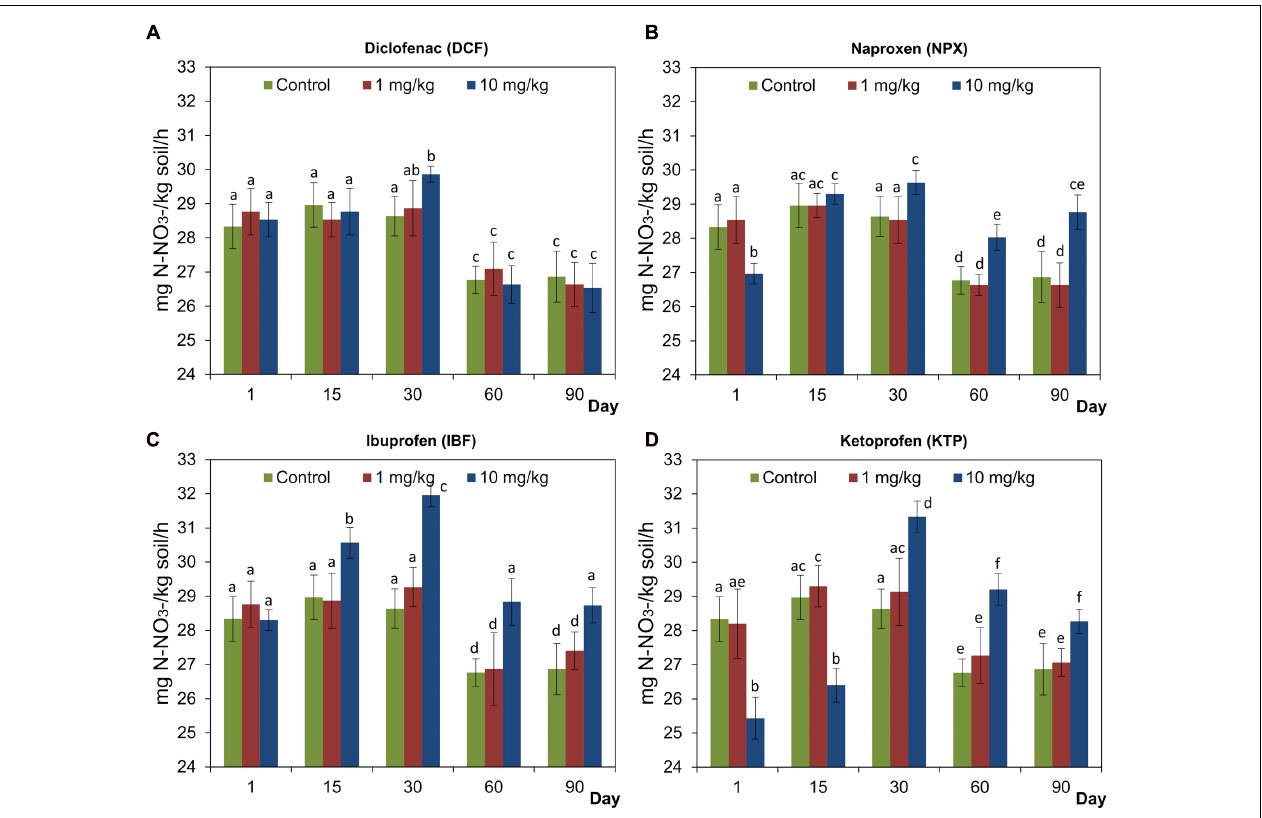
FIGURE 7 | Concentration of N-NO 3 − in control soil and soil treated with diclofenac (A) , naproxen (B) , ibuprofen (C) , and ketoprofen (D) at concentrations of 1 and 10 mg/kg soil during the 90-day experiment. The data presented are the means and standard deviations of three replicates and are expressed as mg N-NO 3 − /kg soil. Different letters (within each drug) indicate significant differences ( P < 0.005, LSD test) related to the effects of concentration and